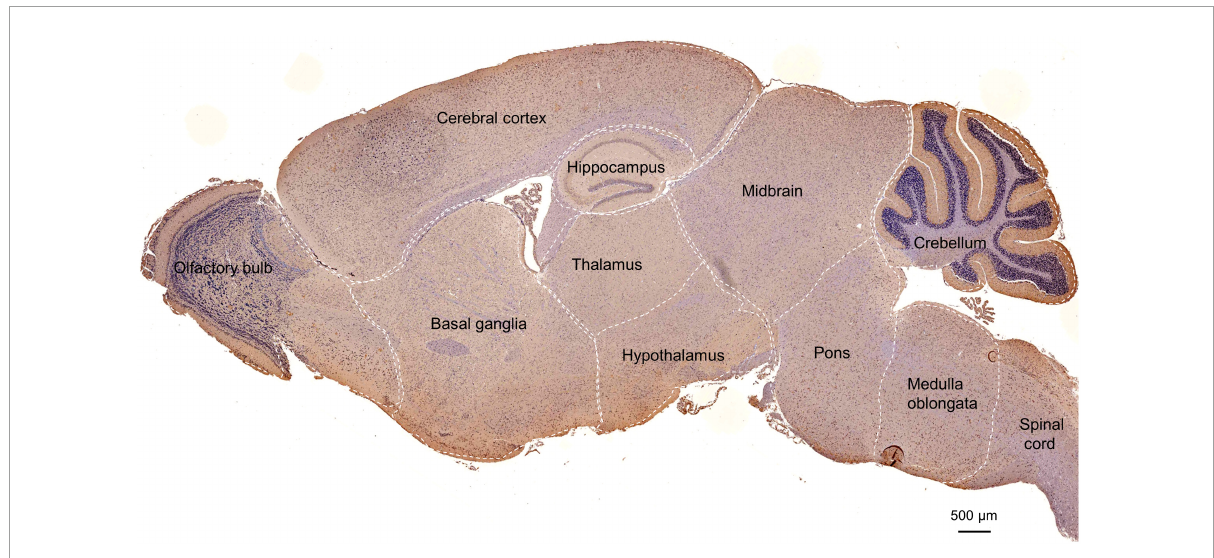
FIGURE2 Overall POMGNT1 distribution patterns of the normal adult mouse brain. IHC staining of POMGNT1 in sagittal brain sections of the male mouse brain at 6 months. The hematoxylin stained nucleus is blue, and the positive expression of POMGNT1 is brownish-yellow. N = 6. Scale bar = 500 µ